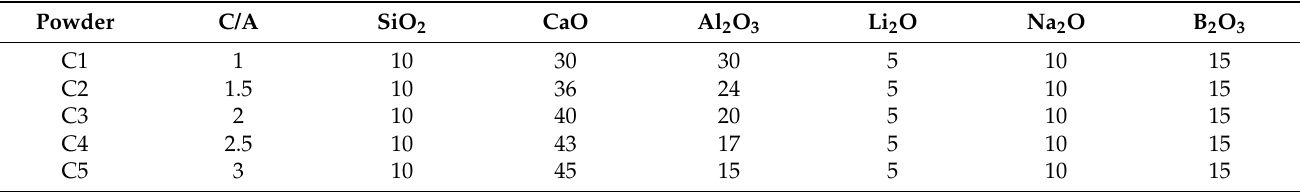
Table 1. Chemical composition of C-series mould powders used in this study (in